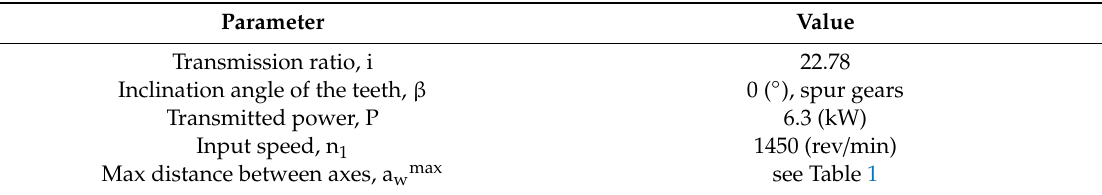
Table 2. Main input parameters of the reducer.